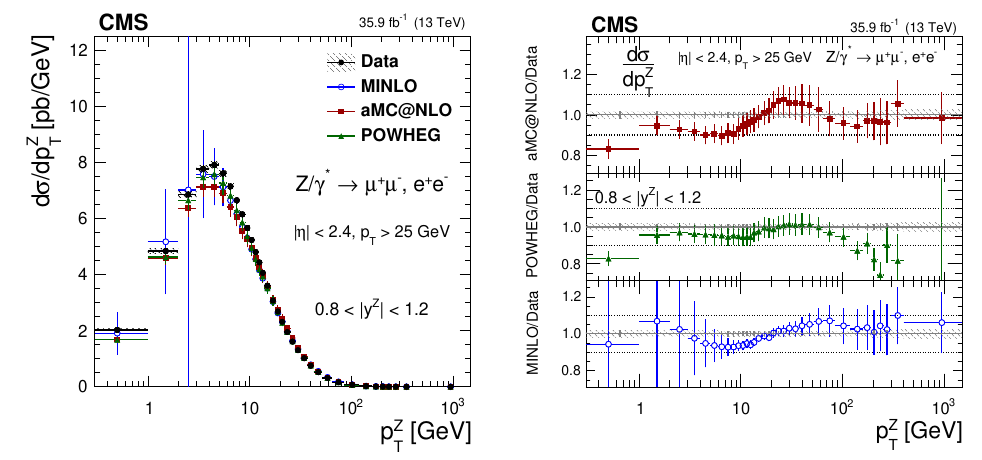
Figure 11 . The measured absolute cross sections (left) in bins of p Z for the 0 : 8 < j y Z j < 1 : 2 region. T The ratios of the predictions to the data are also shown (right). The shaded bands around the data points (black) correspond to the total experimental uncertainty. The measurement is compared to the predictions with MadGraph 5 a mc@nlo (square red markers), powheg (green triangles), and powheg - MINLO (blue circles). The error bands around the predictions correspond to the combined statistical, PDF, and scale uncertainties.